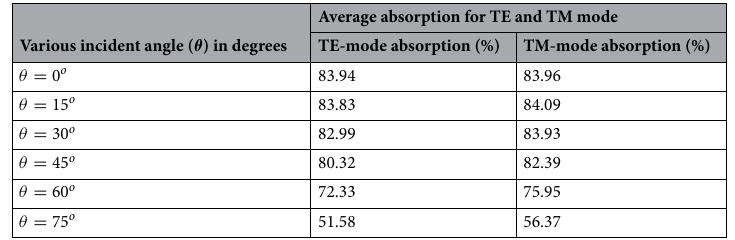
Table 5. Average absorption for different incident angle ( θ ) for TE-mode and TM-mode polarization.